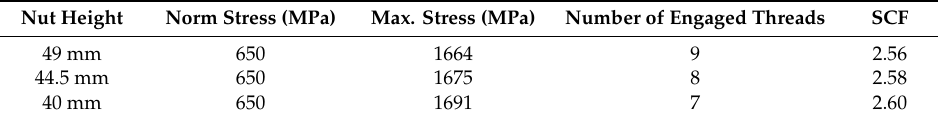
Figure 11. Nut height and number of engaged threads of M42 round nut. Table 7. SCFs based on change of nut height.